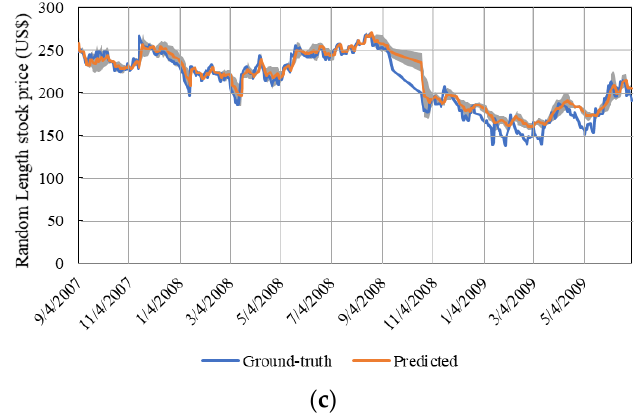
Figure 6. Great recession prediction using LSTM for ( a ) 30 timesteps, ( b ) 60 timesteps, and ( c ) 120 timesteps. Shaded area represents standard deviation.